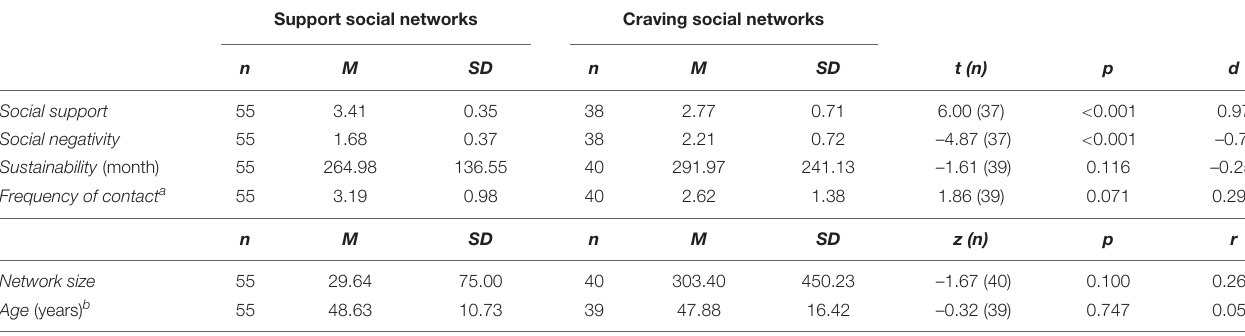
TABLE 1 | Structural and qualitative aspects compared between the Support and the Craving Social Networks. Support social networks Craving social